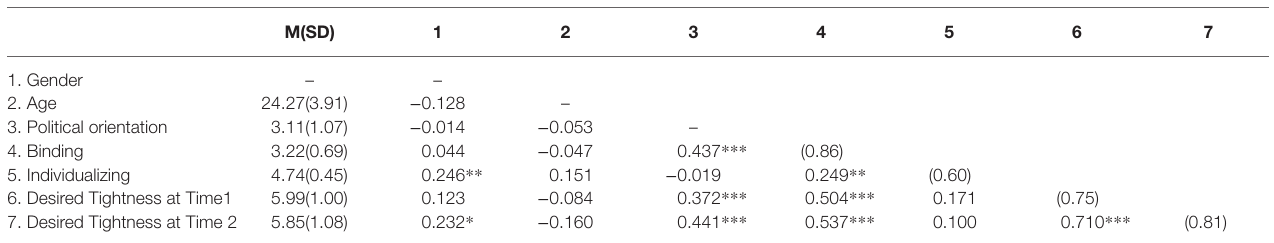
TABLE 3 | Summary of means, standard deviations, and correlations between variables, Study 2.